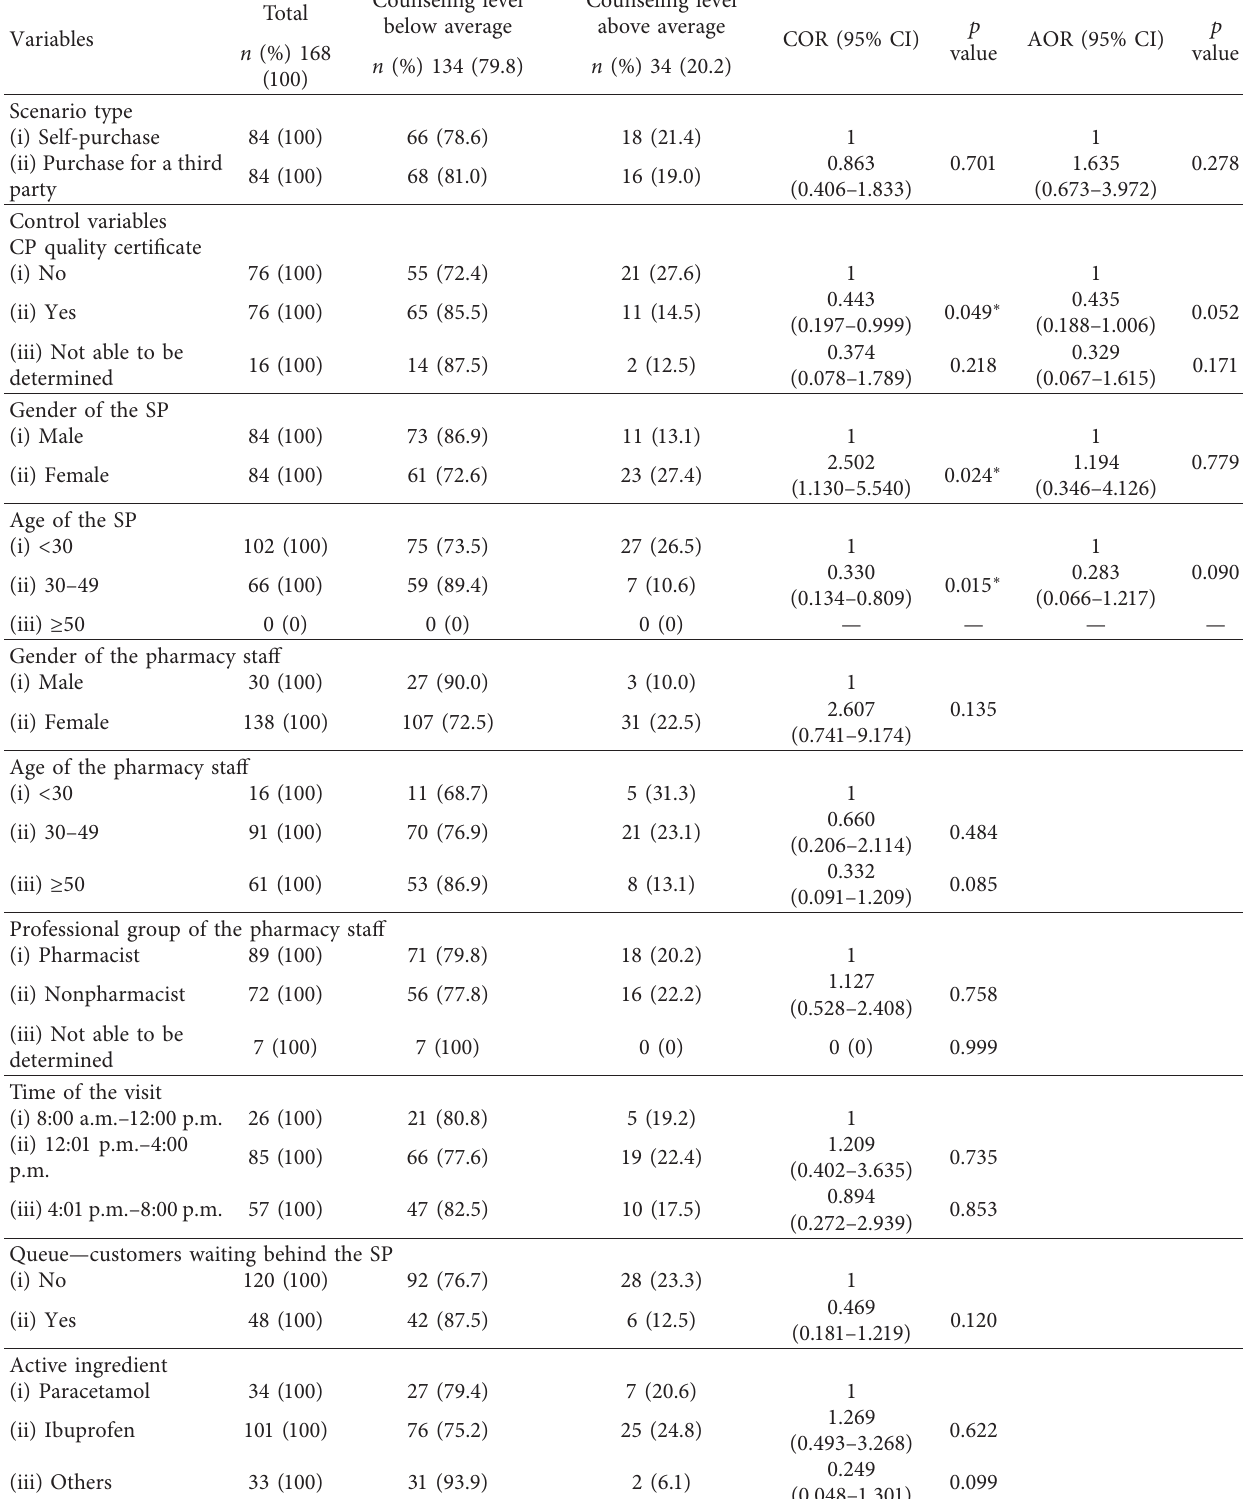
Table 7: Association between counseling level and scenario